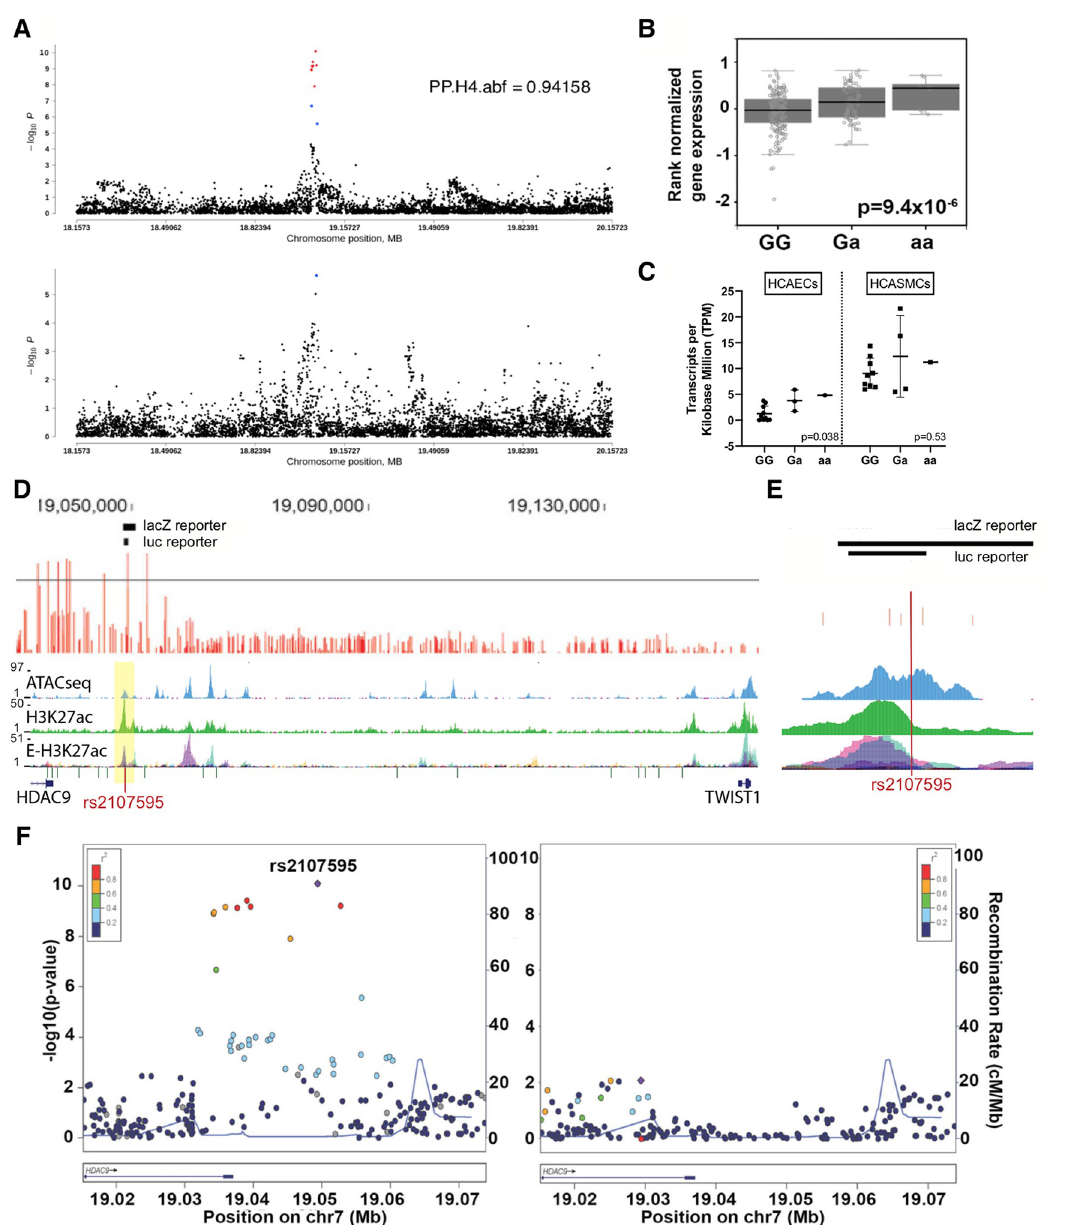
Fig 3. The TWIST1/HDAC9 association locus for CAD and stroke. A) Colocalization analysis of GWAS association with CAD (upper panel) and eQTLs for expression of TWIST1 in human aorta (lower panel). The position on Chromosome 7 (hg19) is plotted on the x-axis, -log10 adjusted P-value on the y-axis. The locus-wide posterior probability that both the GWAS association and the eQTL association are based on the same SNP(s) (PP.H4.abf) is 0.94158. B) TWIST1 expression in human aorta based on rs2107595 genotype (GTEx v7 data, n = 267). C) TWIST1 expression in HCAECs (n = 14) and HCASMCs (n = 14) based on rs2107595 genotype. D) Genomic locus at the rs2107595 association signal for Coronary Artery Disease (CAD). The upper panel in red represents SNPs tested for association with CAD. The line demarcates the p-value threshold of genome-wide significance at 5x10 -8 . Above are depicted the regions assayed in downstream analyses. The panels below the gene annotation track show regions of potentially functional chromatin including regions of open chromatic (ATACseq) in HCASMC, enhancers (H3K27ac) as identified in HCASMC and enhancers identified in multiple ENCODE tissues (E-H3K27ac). E) Close-up of the rs2107595 region. At the top are shown the region tested in vivo for enhancer function in mouse embryo and below in luciferase reporter assays. The lead association SNP falls into a putative functional region. F) Conditional analysis at the rs2107595 association locus for CAD before (left) and after (right) association for linkage. Plotted are all tested SNPs along the genomic coordinate at the locus (x-axis) and their p-value of significance of association for CAD (left y-axis). The right y-axis shows the recombination rate at the locus as a measure of linkage